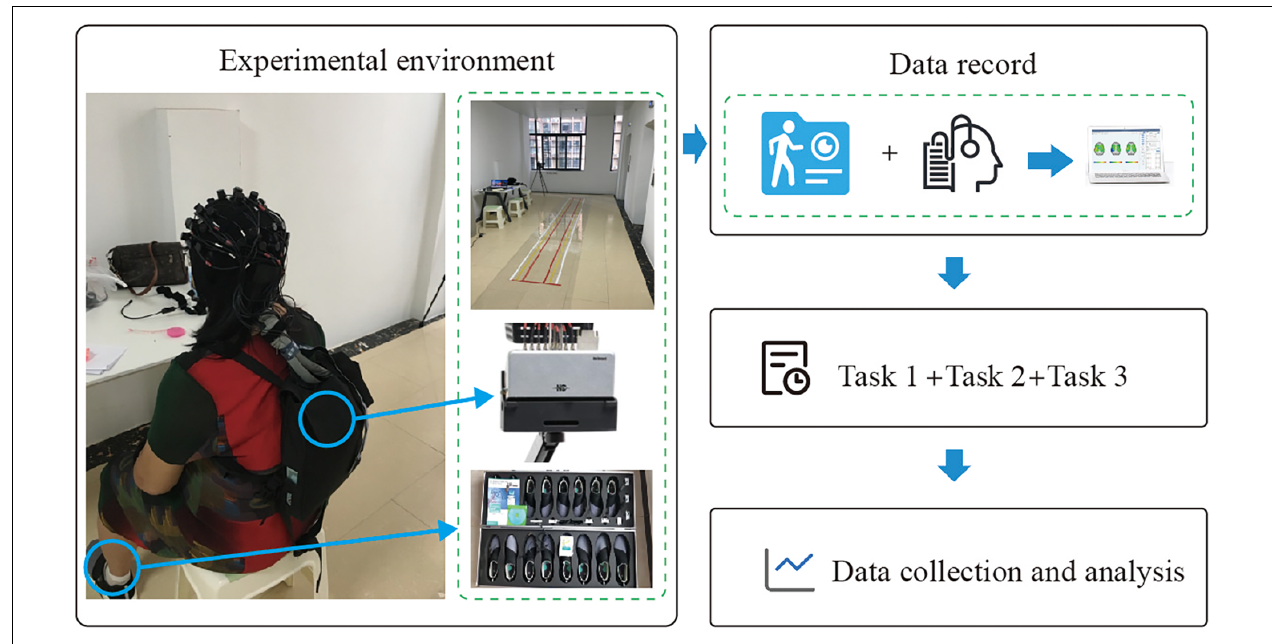
FIGURE 1 | Experimental environment and procedure.